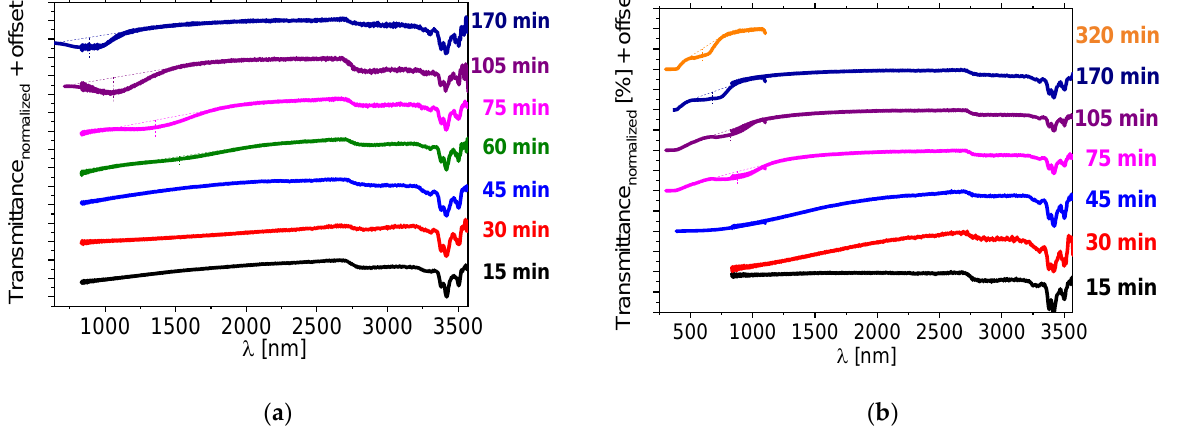
Figure 7. Near-infrared transmission spectra of isothiocyanate-based LC mixture 1825 doped with about 5 wt% of the BNDHP acid and 5 wt% of the [ N 11116 ] Br ( CTAB ) salt after various heating time of the mixture at temperature 150 °C, measured: ( a ) directly after the preparation, ( b ) after one day of storing the sample at the room temperature. Results of the measurements of the samples within a range of (a) 650 – 1100 nm or 700 – 1100 nm, (b) 300 – 1100 nm, for the evaluation of the position of the reflection bands by another UV-Vis-NIR spectrometer are presented by the individual lines with the same color. Dotted lines were used to indicate a shape and a position of the center of the reflection bands.